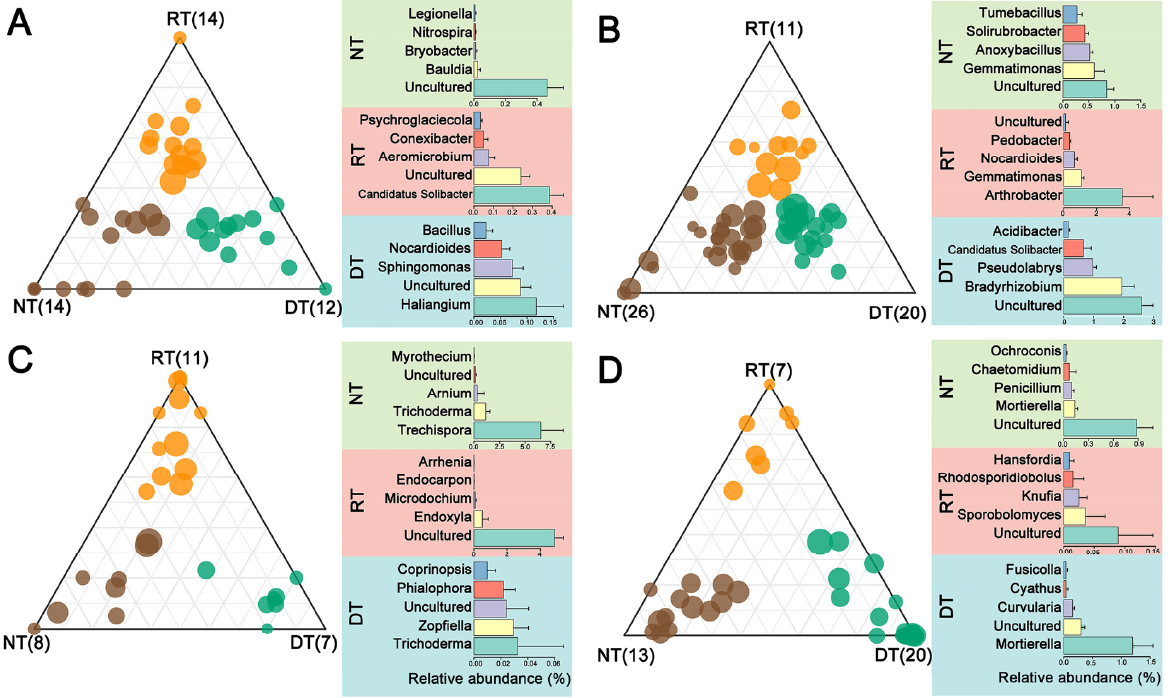
Figure 3. Ternary plots showing the distribution of enriched bacterial OTUs in NT (brown), RT (orange) and DT (green) treatments in 2017 ( A ) and 2018 ( B ); the enriched fungal OTUs in the NT, RT and DT treatments in 2017 ( C ) and 2018 ( D ). The size of each circle is equivalent to its relative abundance. The most abundant five genera are displayed in bar plots.